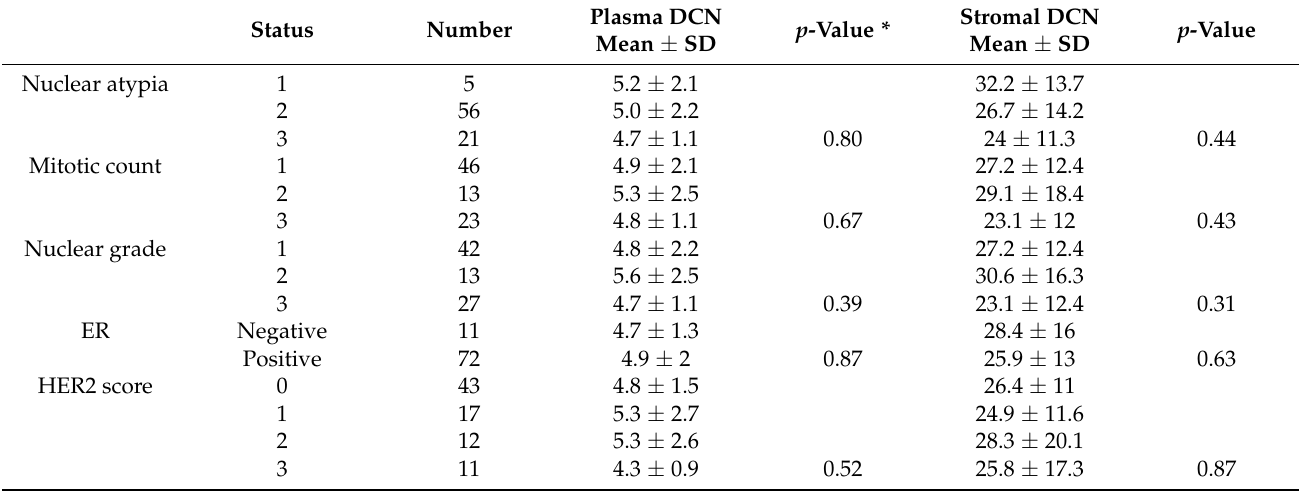
Figure A1. Digital image analysis of stromal DCN expression. The immunostained specimens were viewed using a light microscope, and stromal areas at the periphery of tumors were captured as digital images with a digital camera. For each digital image, the signal was digitized into a grayscale ranging from 0 (white) to 255 (black). Scale bars indicate 500 µ m. Table A1. The association of plasma decorin or stromal decorin and tumor characteristics in